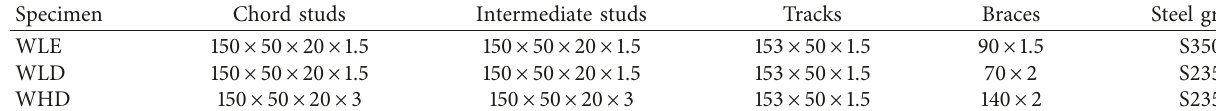
Figure 8: Load-deflection verification curve of test versus FE (specimen 45AM). Table 4: Landolfo’s CFS walls elements dimensions.